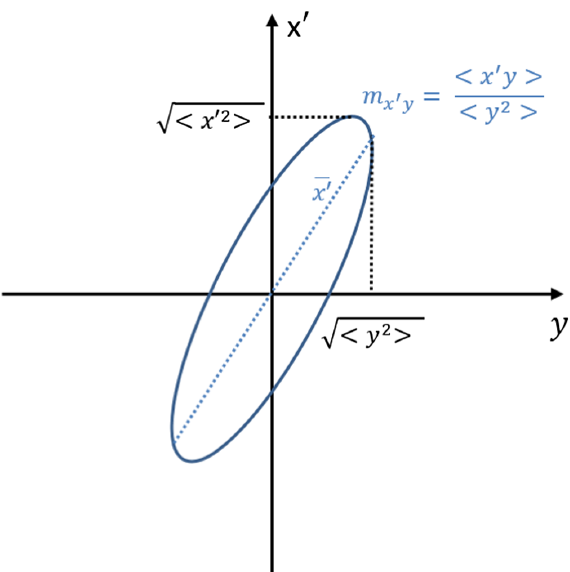
FIG. 2. Projection of the four-dimensional rms-ellipsoid onto the ð y; x 0 Þ plane and the constant slope ∂